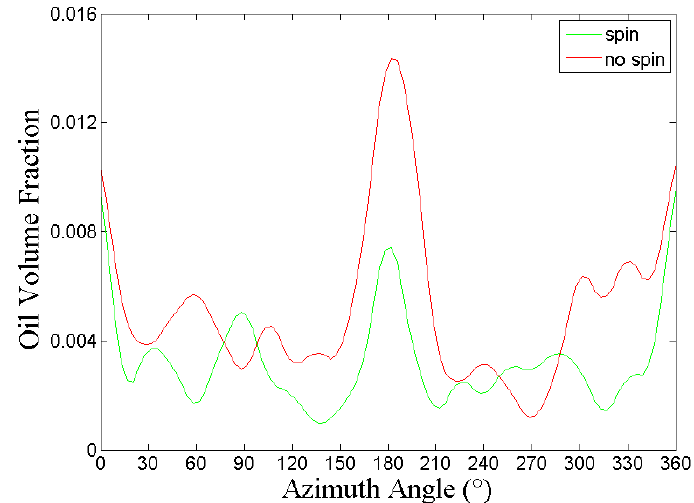
Figure 12. Oil volume fraction around the circumference, with or without spin.